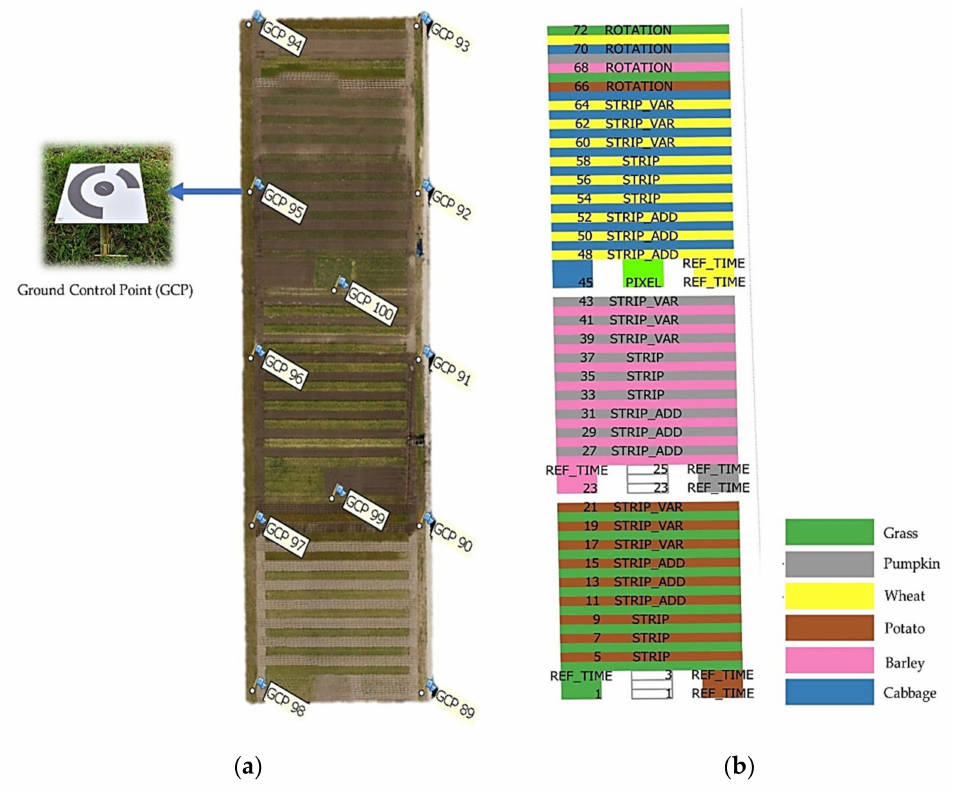
Figure 1. Field experiment overview for 2020; ( a ) strip cropping in the experimental strip cropping field at the Droevendaal organic experimental farm in Wageningen, the Netherlands—the location of the ground control points (GCP); ( b ) experimental design of the experimental strip cropping field. The labels in the strips refer to different strip cropping treatments: STRIP_VAR (mixed variety strips), STRIP_ADD (main crop and legume), and STRIP (sole crop strips). The strips for ROTATION, REF_TIME, and PIXEL were not included in this